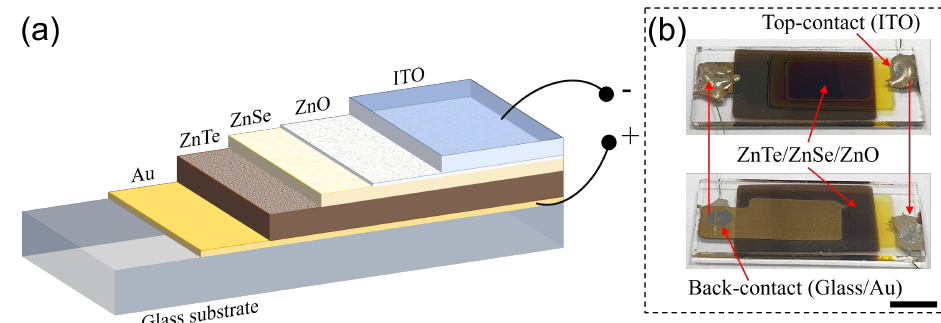
Figure 1. ( a ) Schematic representation of the Au/ZnTe/ZnSe/ZnO/ITO sub-micrometric structure prepared onto an optical glass substrate; ( b ) corresponding top- and back-side CCD images of the prepared structure. The scale bar is 5